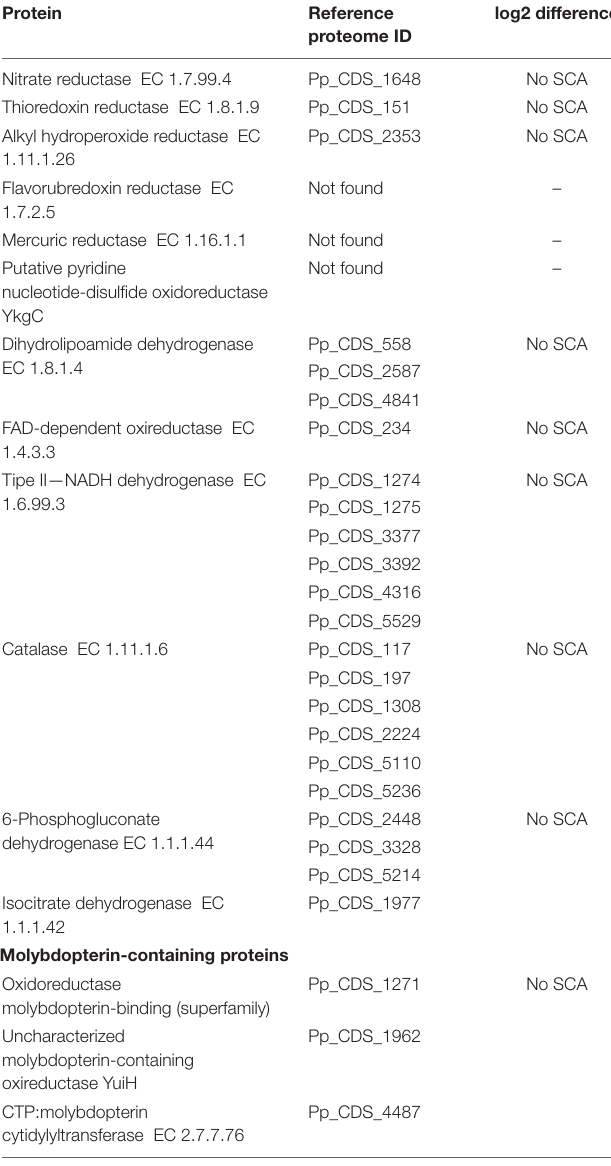
TABLE 2 | Identification of known proteins with Te (IV)-reducing ability and proteins with putative Te (IV)-reducing ability in the Paenibacillus pabuli ALJ109b reference proteome with abundance change (SCA) when strain ALJ109b grows in the presence of 5 × 10 − 4 M of Te (IV). Protein